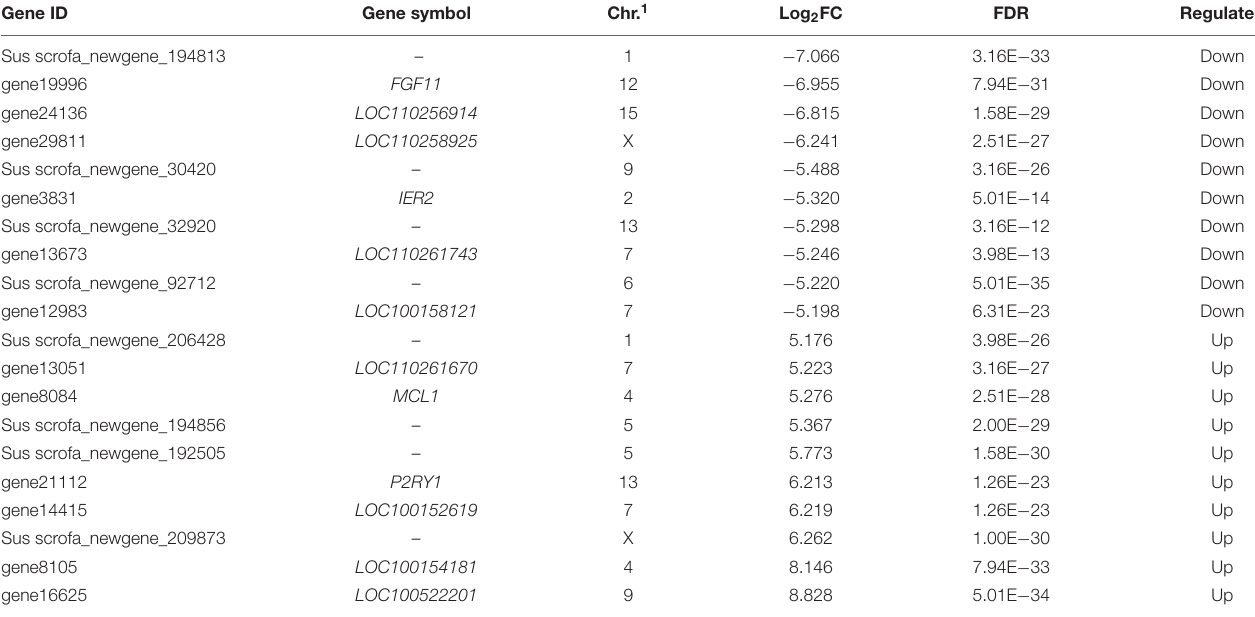
TABLE 1 | Top 10 down- and up-regulated DEmRNAs in NORFA -inhibited porcine GCs. Gene ID Gene symbol Chr. 1 Log 2 FC